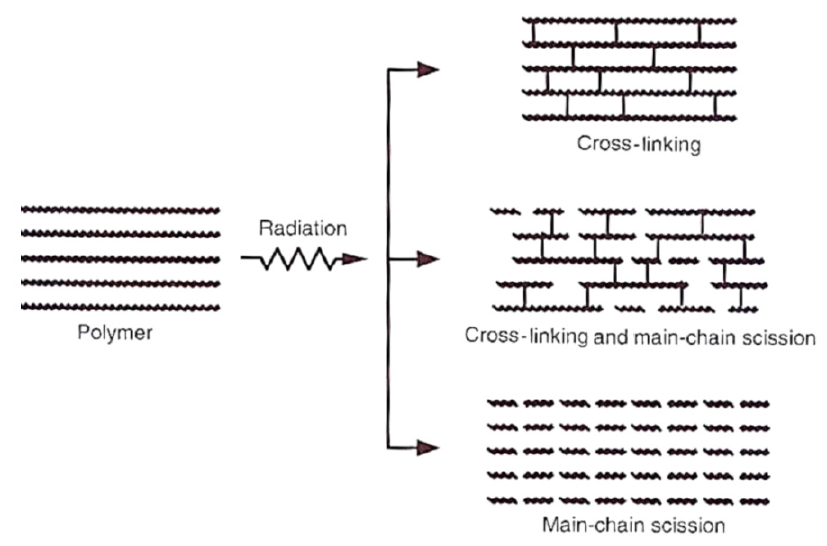
Figure 1. Influence of electron rays on polymers [3].